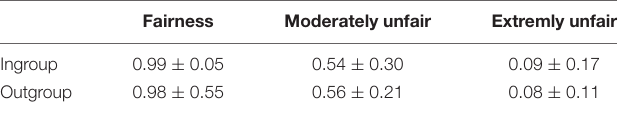
TABLE 1 | Acceptance rate of subjects under different group membership (M ± SD) unit:%.